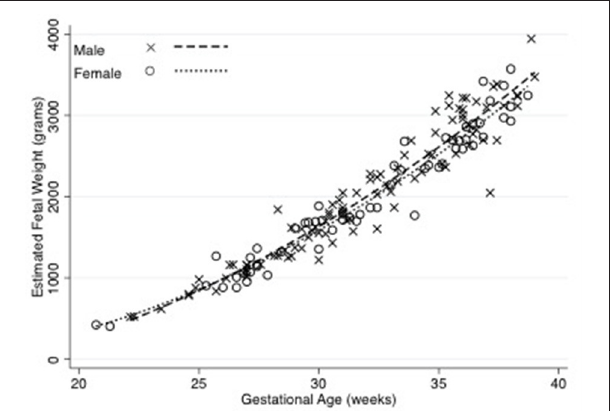
FIGURE 1 | Estimated fetal weight in male and female fetuses across gestation. There was no significant difference in estimated fetal weights of male and female fetuses. The relationship between fetal weight and gestation were derived using non-linear regression. N = 100 male and 61 female observations. Equations are: male estimated fetal weight = 868–120.7 (Gestational Age) + 4.86 (Gestational Age 2 ) ( R 2 = 0.93), female estimated fetal weight = 1143.96–135.22 (Gestational Age) + 4.98 (Gestational Age 2 ) ( R 2 =